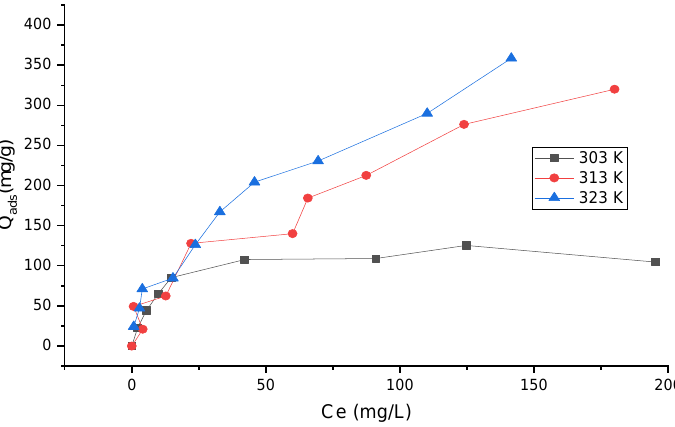
Figure 4. Adsorption isotherms of MB on OR-KOH adsorbent as a function of temperature.